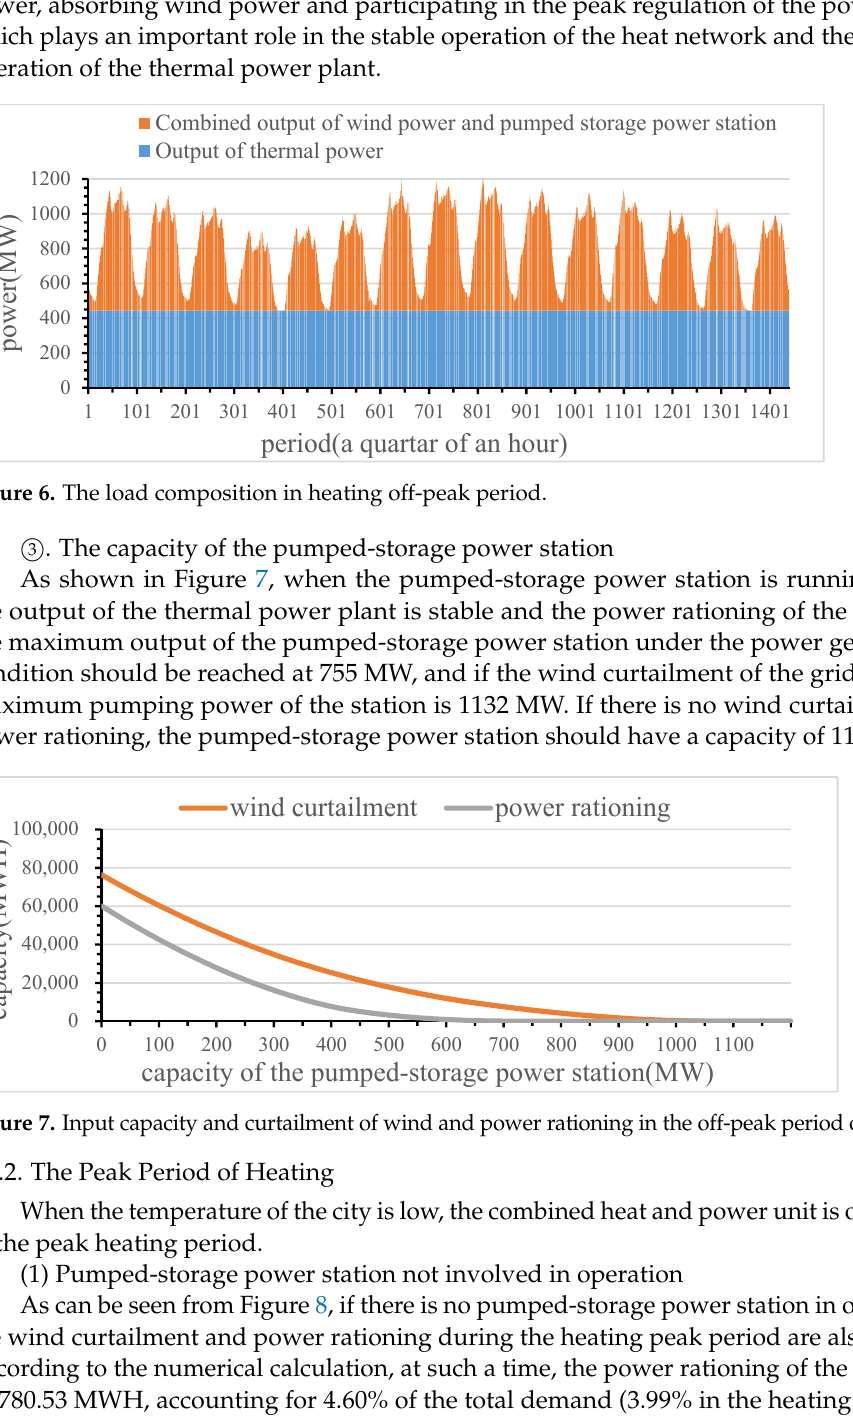
Figure 5. Operation of pumped-storage power station in heating off-peak period.